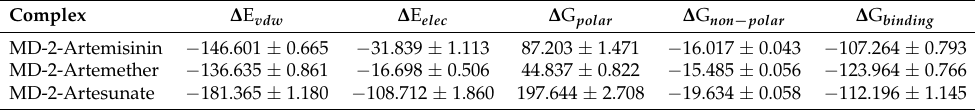
Figure 9. Per-residue decomposition of binding free energy contributions of ( A ) MD-2-Arteminsinin complex, ( B ) MD-2-Artemether complex, and ( C ) MD-2-Artesunate complex. Free energyies less than − 2KJ · mol − 1 are highlighted in blue. Table 1. Binding energies of protein-ligand complexes obtained using